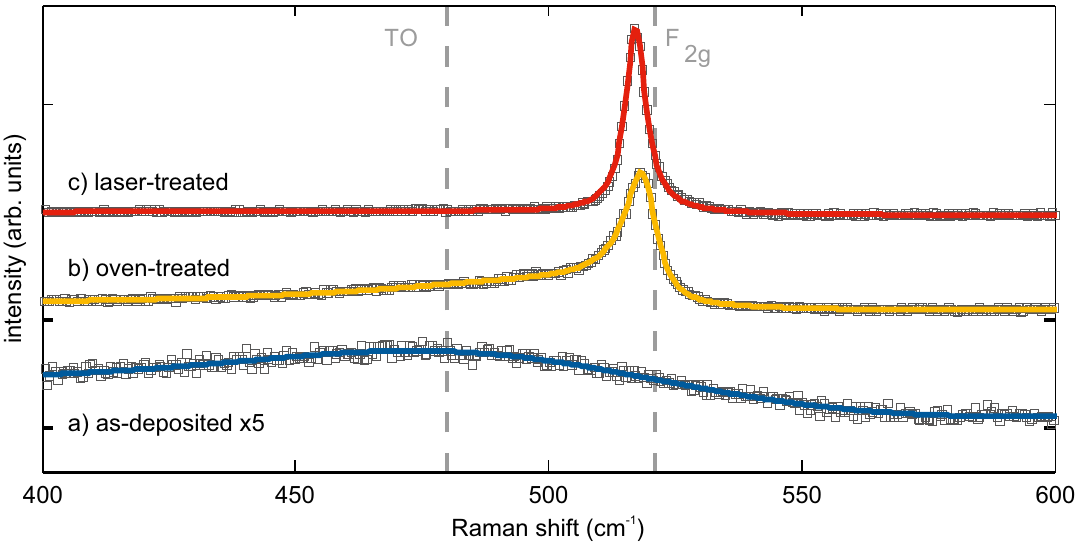
Figure 2. Raman spectra of SiO 0.6 layers on SiO 2 : as-deposited ( a ), after conventional oven ( b ) and after laser treatment ( c ). Grey squares represent measured spectral data points and solid lines fitted spectra. Dashed lines indicate the expected positions of the TO-like band associated with a-Si and the F 2 g phonon mode of